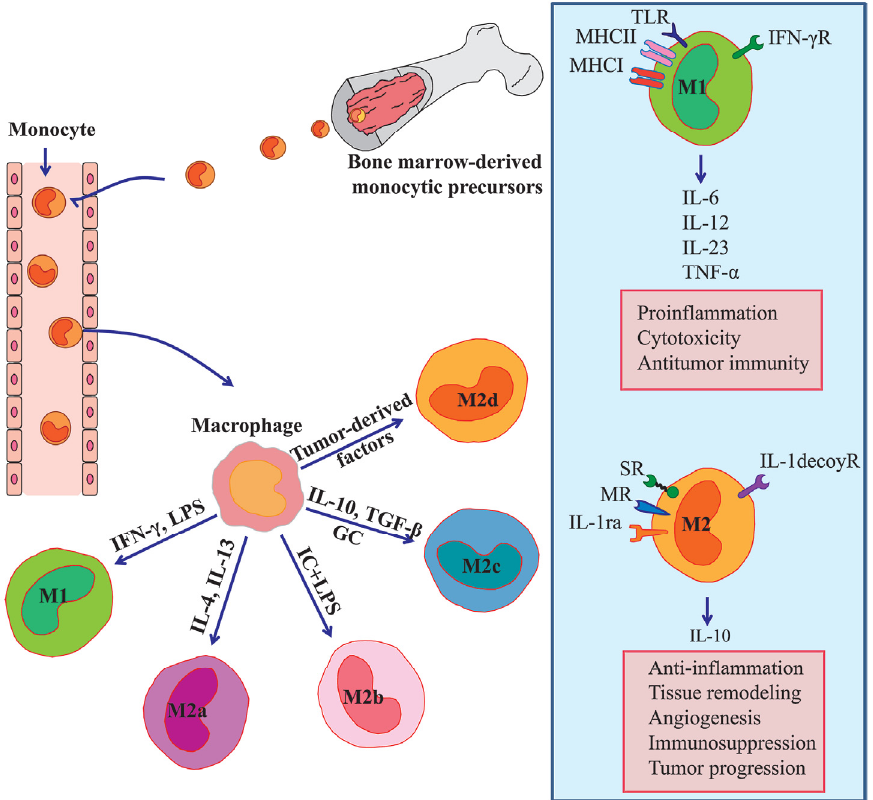
Figure 1. Macrophage polarization and its function. Tissue macrophages are derived from circulating monocyte and acquire either a classical M1 or alternative M2 phenotype depending on microenvironmental stimuli. M1 phenotype is driven by IFN- γ and LPS, and produce high levels of the pro-inflammatory cytokines such as IL-6, IL-12, IL-23, and TNF- α . M2 phenotype can be subdivided into M2a, M2b, M2c, and M2d according to different stimuli. M2 macrophages generally produced a high level of IL-10 and demonstrated with high levels of scavenger receptor, mannose receptor, IL-1 receptor antagonist, and IL-1 decoy receptor. M1 phenotype drives pro-inflammatory, cytotoxic and antitumor responses. In contrast, M2 phenotype promotes angiogenesis, immunosuppression, and tumor progression. LPS indicates lipopolysaccharide; IC, immune complex; GC, glucocorticoid; SR, scavenger receptor; MR, mannose receptor; IL-1ra, IL-1 receptor antagonist; TLR, Toll-like receptor; MHC, major histocompatibility